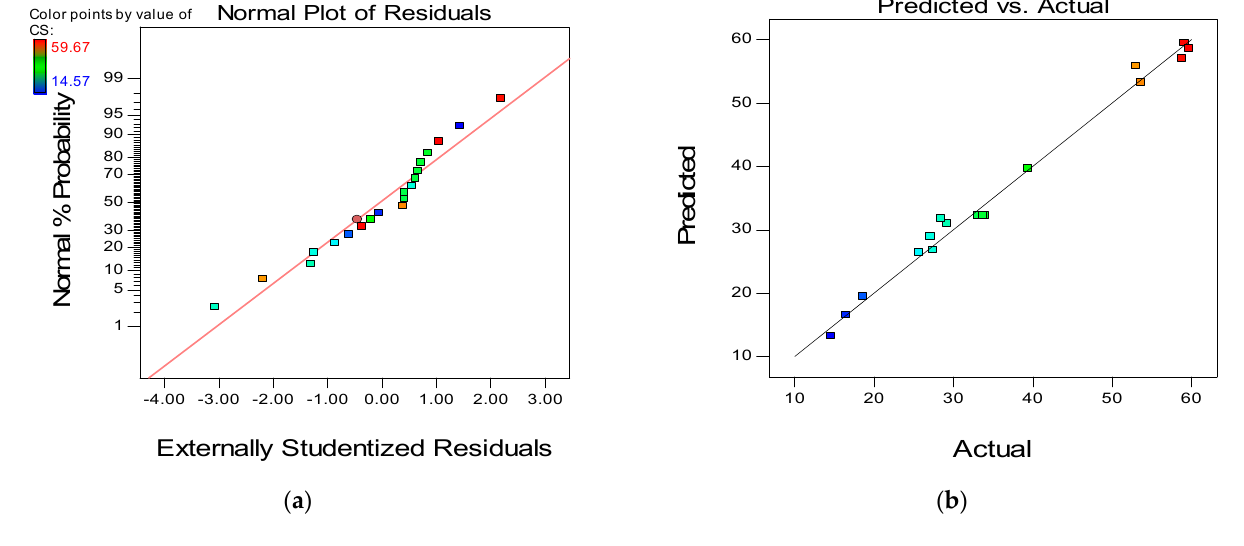
Figure 12. ( a ) Normal plot of residuals and ( b ) predicted versus actual plot for compressive strength.